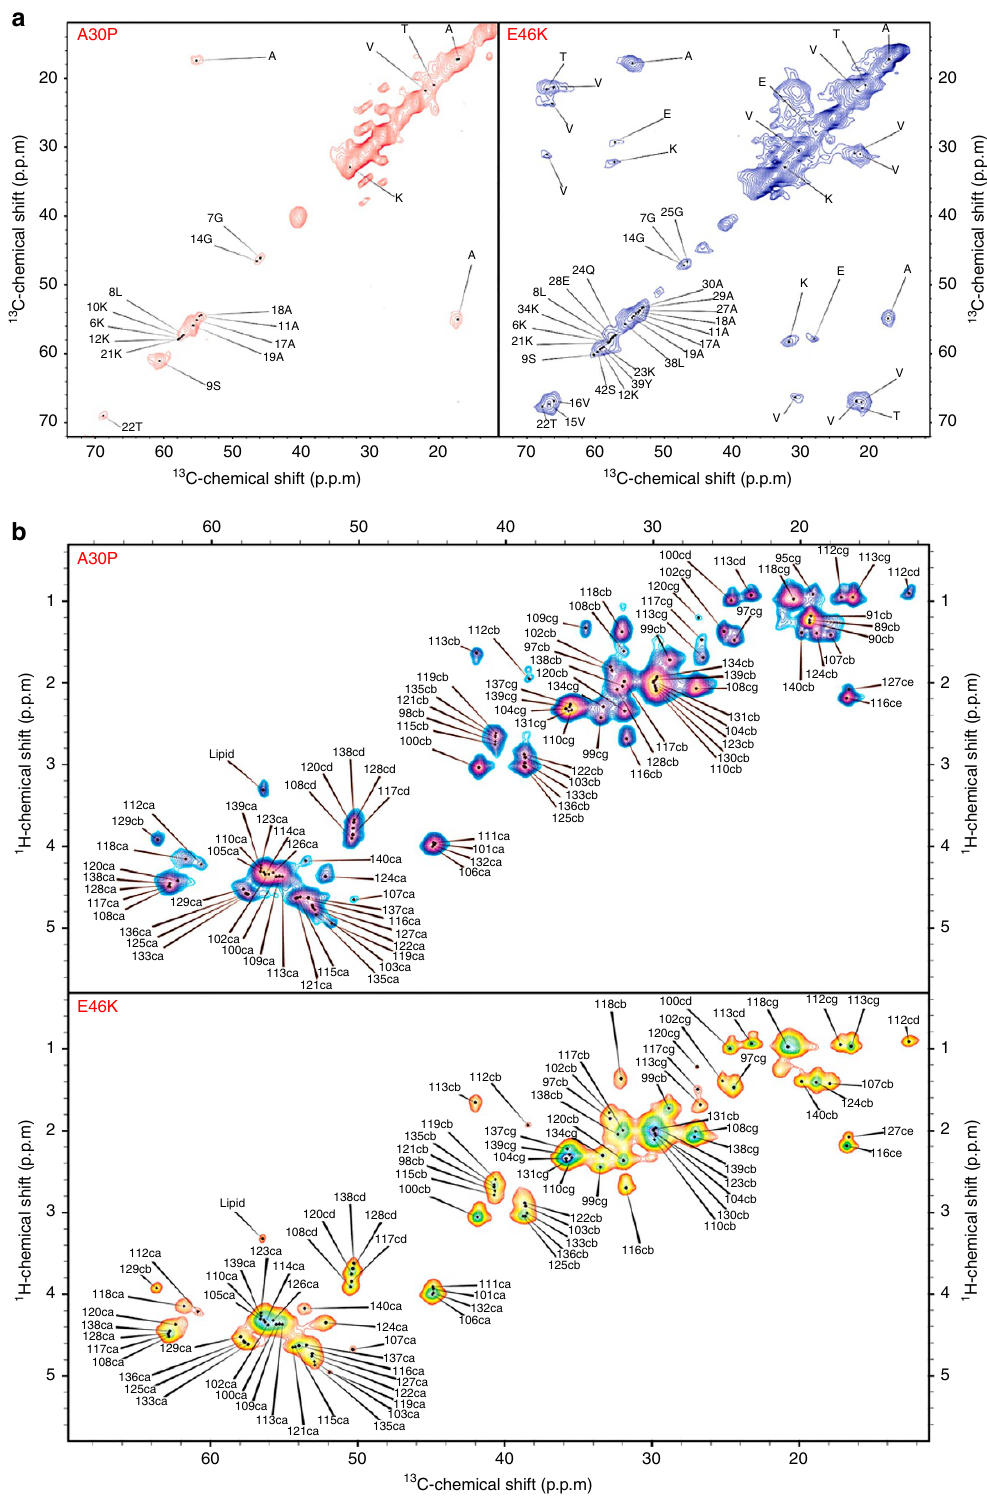
Figure 2 | MAS ssNMR spectra of a S A30P and a S E46K bound to SUVs. ( a ) 13 C– 13 C DARR correlation spectra (aliphatic regions) recorded at (cid:2) 19 (cid:2) C using a 50ms mixing time at a MAS rate of 10kHz. We used a 1:65 protein:lipid ratio in both cases, and spectra of a S A30P and a S E46K are shown in the left and right panels, respectively. Residues are indicated using the single letter convention. The highest signal intensities in the spectra of the samples studied here were obtained by performing the measurements at (cid:2) 19 (cid:2) C. Under these conditions the lipid mixtures used here are in the gel phase 70 , enabling 13 C– 13 C DARR spectra to be measured with significantly increased signal-to-noise ratios but without affecting the pattern of chemical shifts; the latter are consistent with those measured at 4 (cid:2) C (ref. 28). No variations in the number of observed resonances or in the chemical shifts were observed using protein:lipid ratios ranging from 1:30 to 1:200 (ref. 28). ( b ) 1 H– 13 C correlation via INEPT transfer recorded at 4 (cid:2) C at a MAS rate of 10kHz. The experiments were performed at a 1 H frequency of